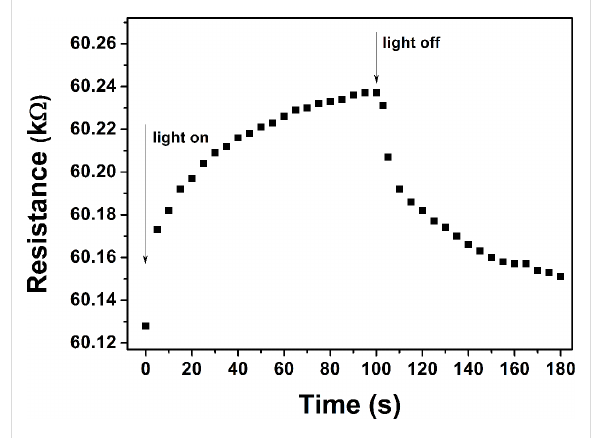
Figure 6: Modification of the Au nanostructure resistance by irradia- tion with infrared